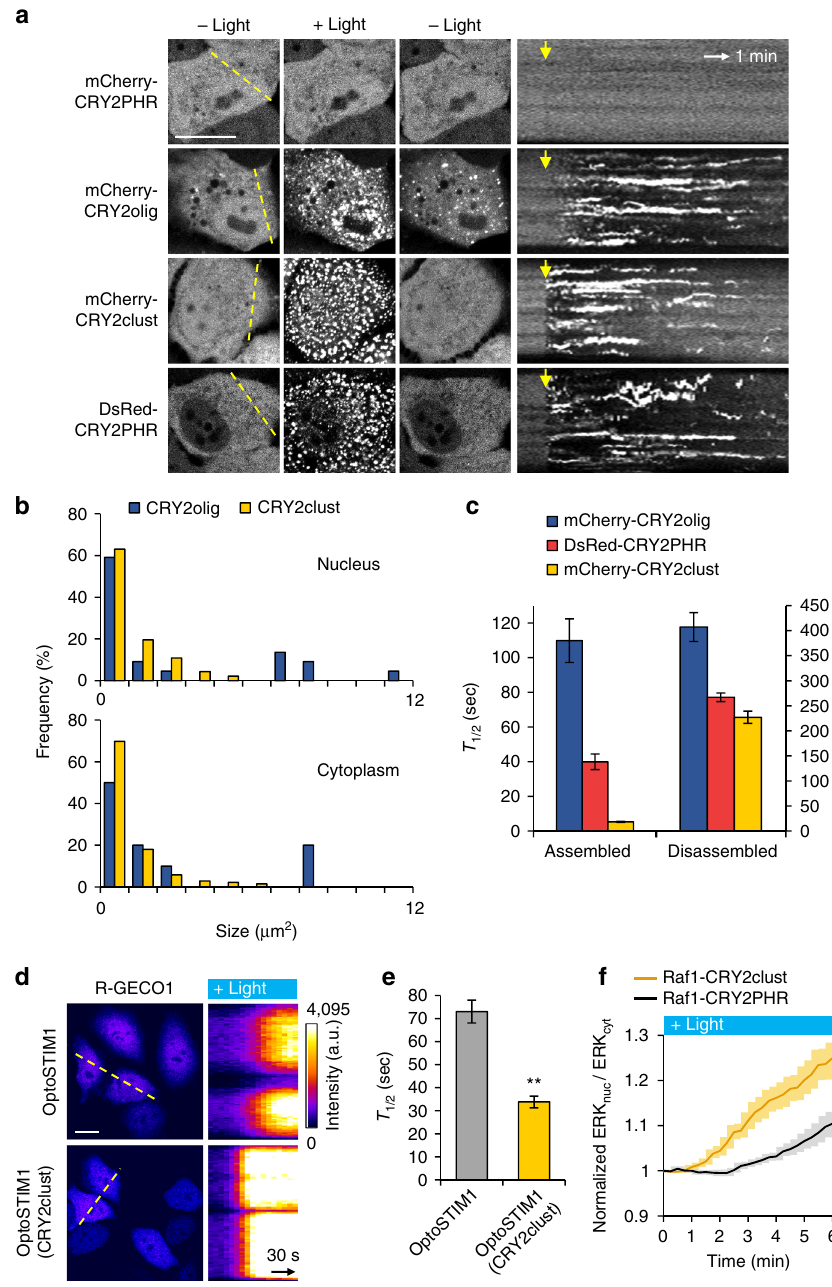
Fig. 3 Comparison of characteristics of CRY2-based clustering modules. a Fluorescence images of cells expressing each of the indicated constructs following exposure to blue light for 1 s. Right , kymographs corresponding to yellow lines in left images. Yellow arrows indicate illumination time points. b Size distribution of clusters in the nucleus ( top ) and in the cytoplasm ( bottom ) in cells expressing either CRY2olig or CRY2clust. c Graph showing time to reach half-maximal and basal cluster ratio ( T 1/2 ) for assembly and disassembly, respectively ( n = 29, 35, 34 cells). d Fluorescence images of R-GECO1 in cells coexpressing either OptoSTIM1 or OptoSTIM1 (CRY2clust). Right , kymographs corresponding to yellow lines in left images. e Graph showing time to reach half-maximal R-GECO1 fl uorescence after light illumination in cells expressing the indicated construct ( n = 62, 75 cells). ** P = 3.65 × 10 – 10 by Student ’ s two-tailed t -test. f The normalized nuclear/cytoplasmic ERK2-EGFP ratio upon light illumination on cells expressing the indicated optogenetic Raf1 module ( n = 32, 48 cells). Values are expressed as means ± s.e.m. Scale bars, 20 μ